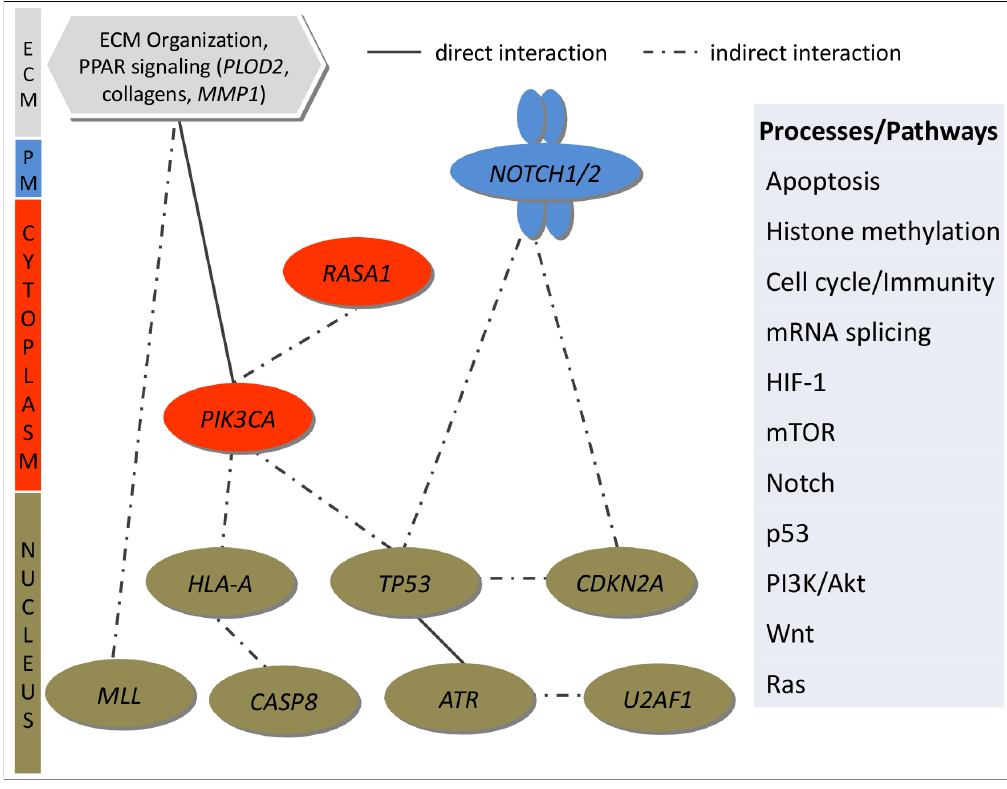
Figure 6. Significantly affected pathways in OTSCC. Genes harboring significant somatic variants and with expression changes in tumors were used in Cytoscape to derive a set of important signaling pathways implicated in